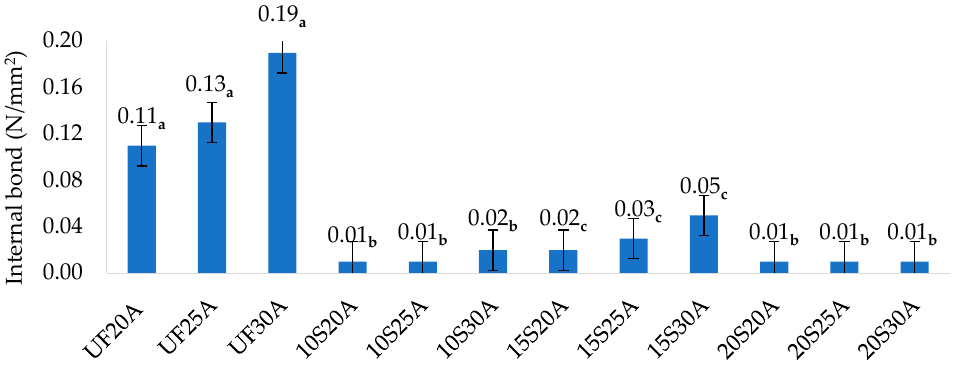
among the parameters